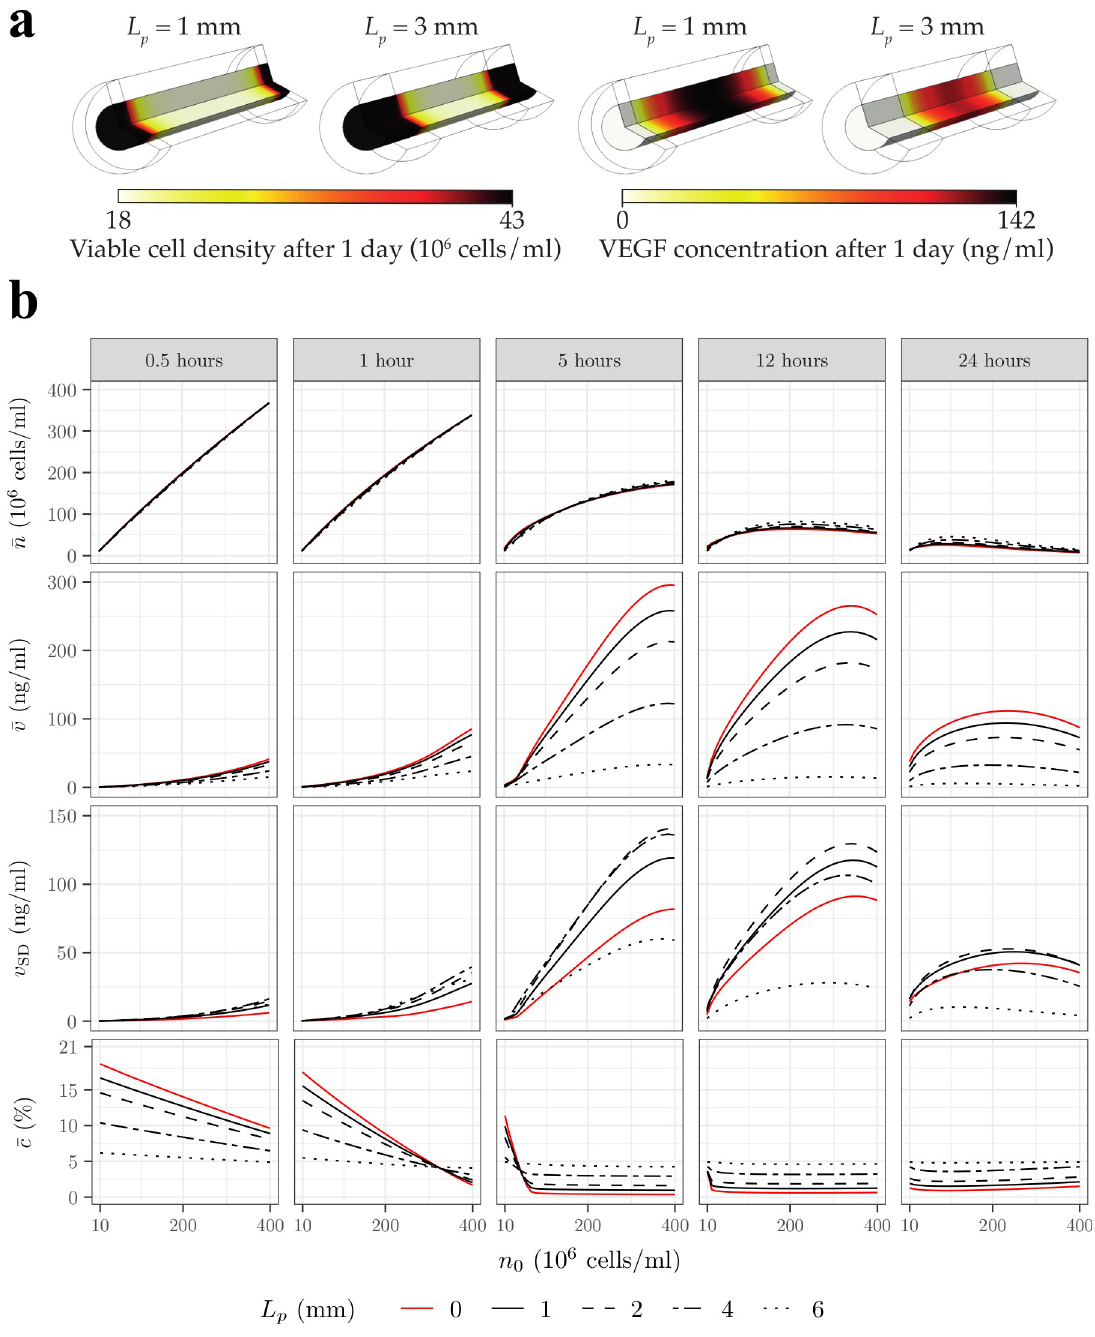
Fig 9. A partially porous sheath with a moderate length L p limits the decrease of VEGF concentration while still increasing cell density and oxygen concentration after 24h. A) Heatmaps of cell density and VEGF concentration after 1 day, for two different porous sheath zone lengths L , for an initial cell density n 0 = 1.78 × 10 6 cells/ml. B) Mean cell density � n � , mean oxygen concentration � c � and mean p VEGF concentration � v � and standard deviation v SD , as functions of the initial cell density n 0 , for different L B) the porous sheath structure is approximated by an array of overlapping spheres (see Table 1) with a thickness T = 0.25mm and a porosity � = 0.8. We note that L p = 0 (red lines) corresponds to an impermeable sheath.